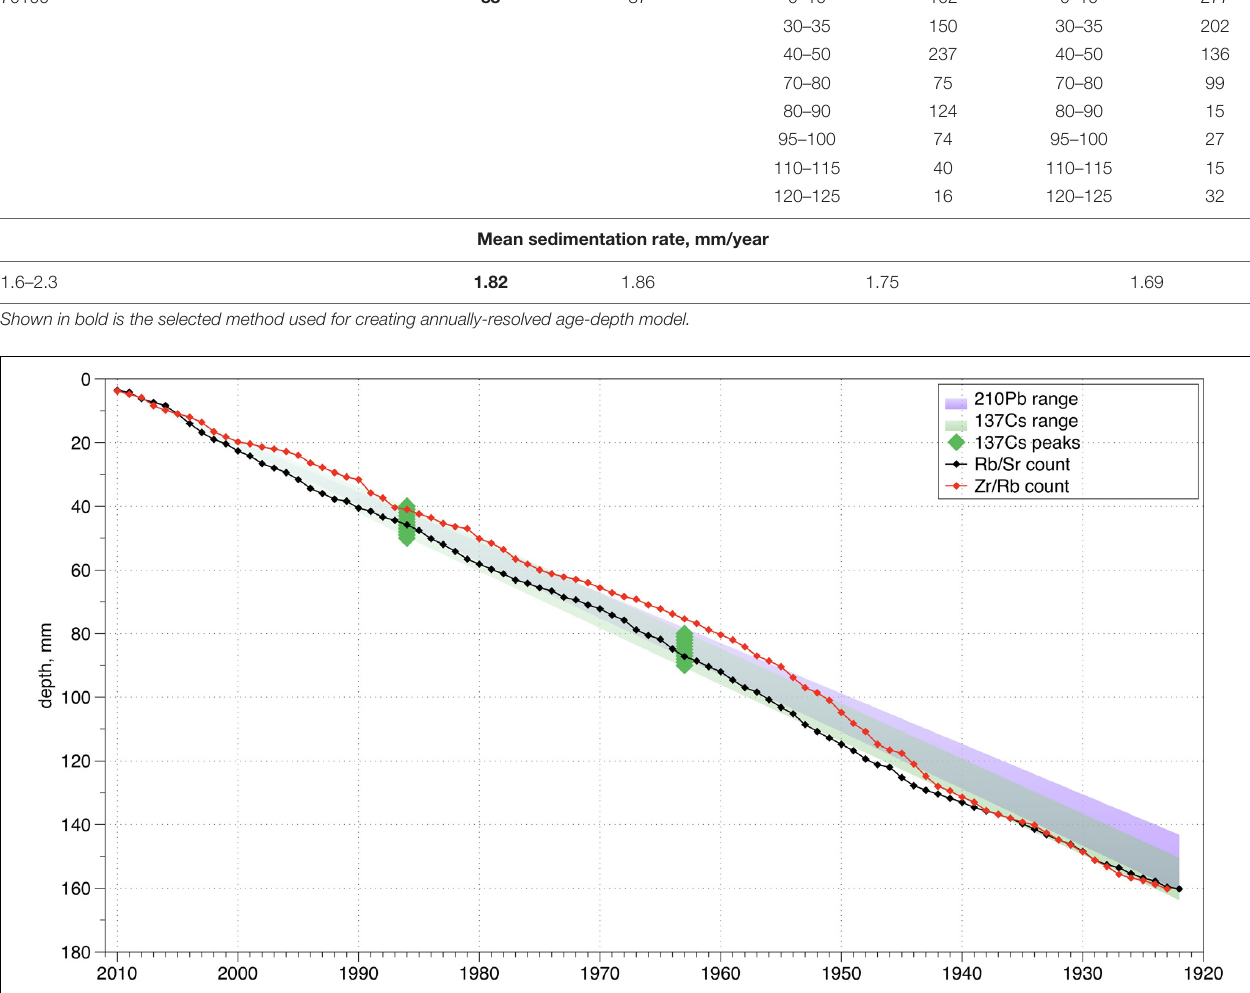
load of the glaciofluvial streams and intensity of surface